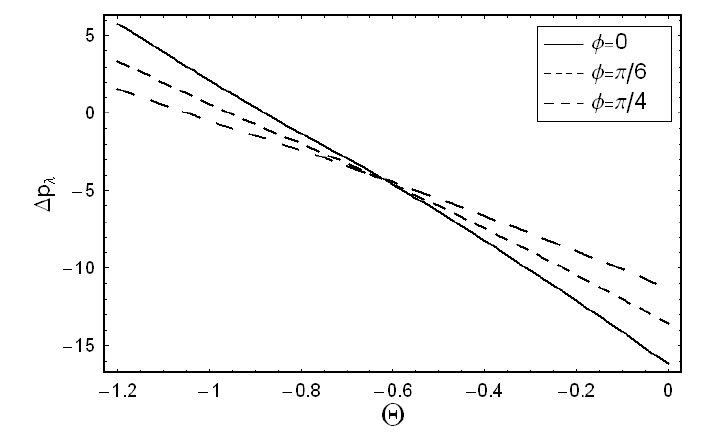
Figure 6. Variation in ∆ p λ versus Θ for φ with a = 1.0, b = 0.7, d = 1.2, n = 1.5 and b ∗ =